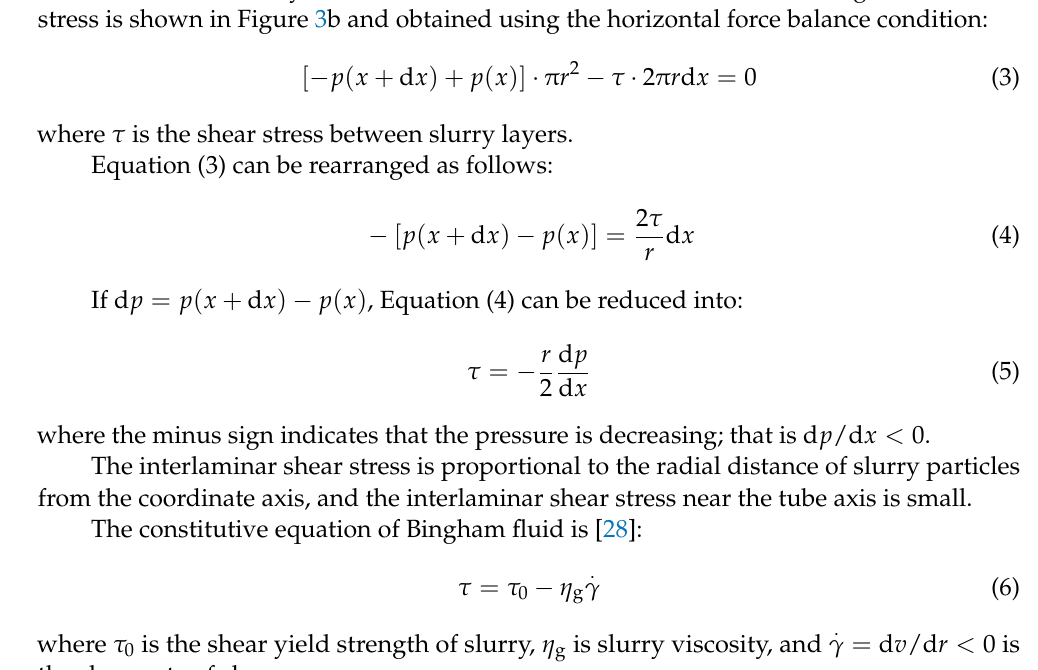
micro element fluid micro element stress.